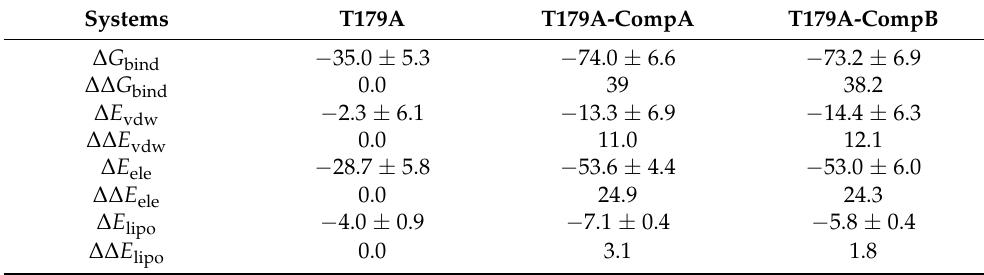
Table 3. The binding energies calculated for the last 50 ns of each